Question: Draft a figure caption describing what is shown.
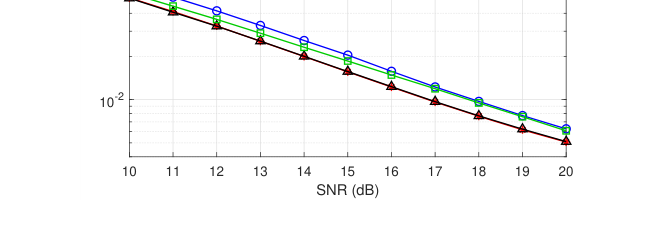
Answer: shows the BER performance of the decoding schemes with convolutional codes in Rayleigh fading channels. The proposed soft-decision decoding scheme outperforms the